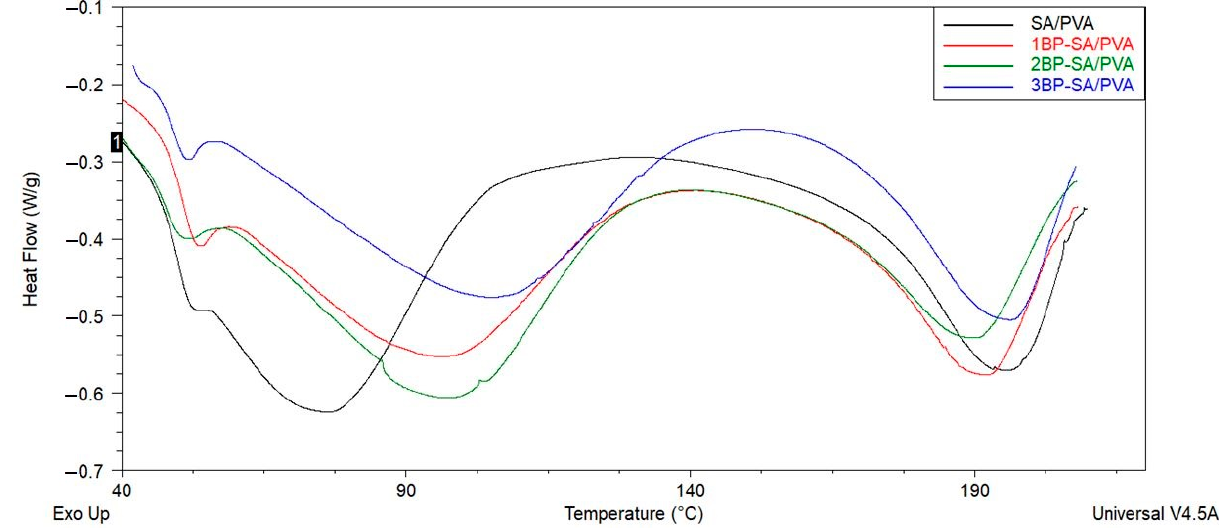
Figure 5. DSC thermograms of the electrospun SA/PVA and bee pollen ‐ loaded SA/PVA nanofibers.